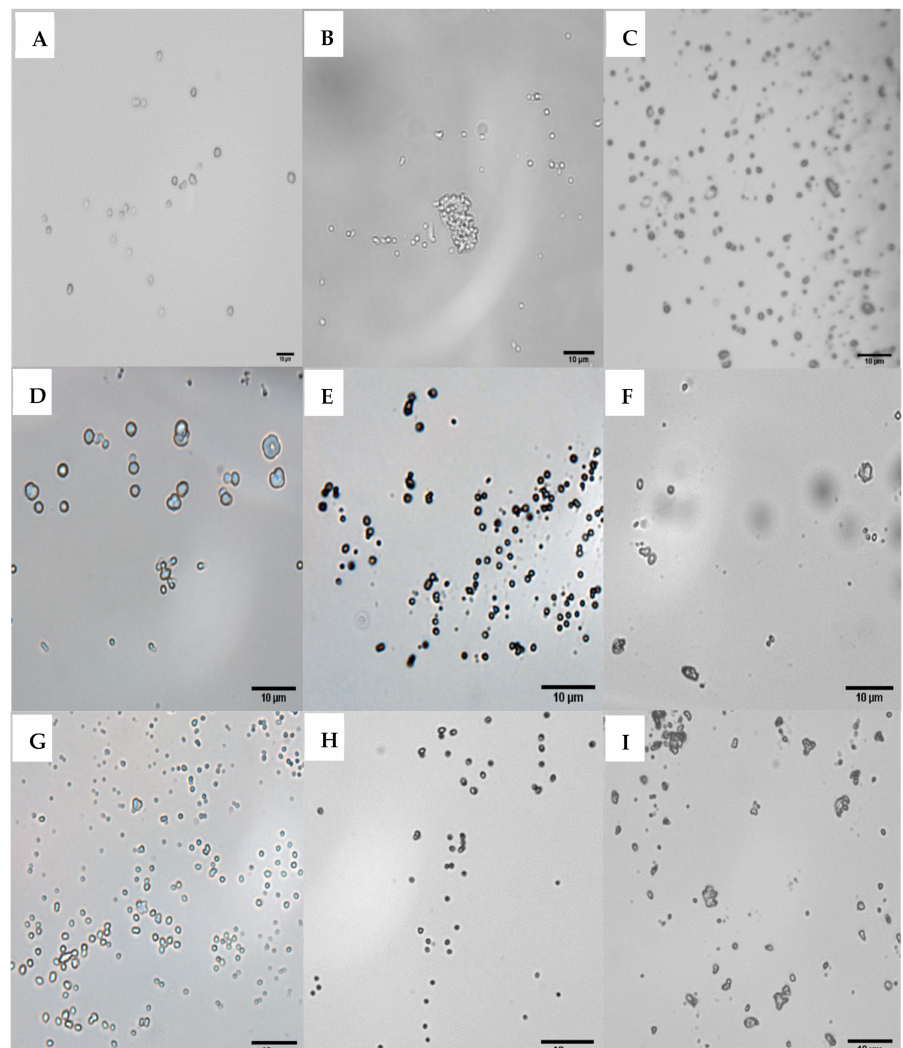
Figure 3. Light microscopy (40 × ) images of calcium alginate microparticles produced using water-in- oil (top row) and ionic gelation (middle and bottom rows, without and with poly-L-lysine, respec- tively) with different types of alginates. ( A , D , G ) were produced using medium-viscosity alginate, ( B , E , H ) using low-viscosity alginate, and ( C , F , I ) using Protanal ®